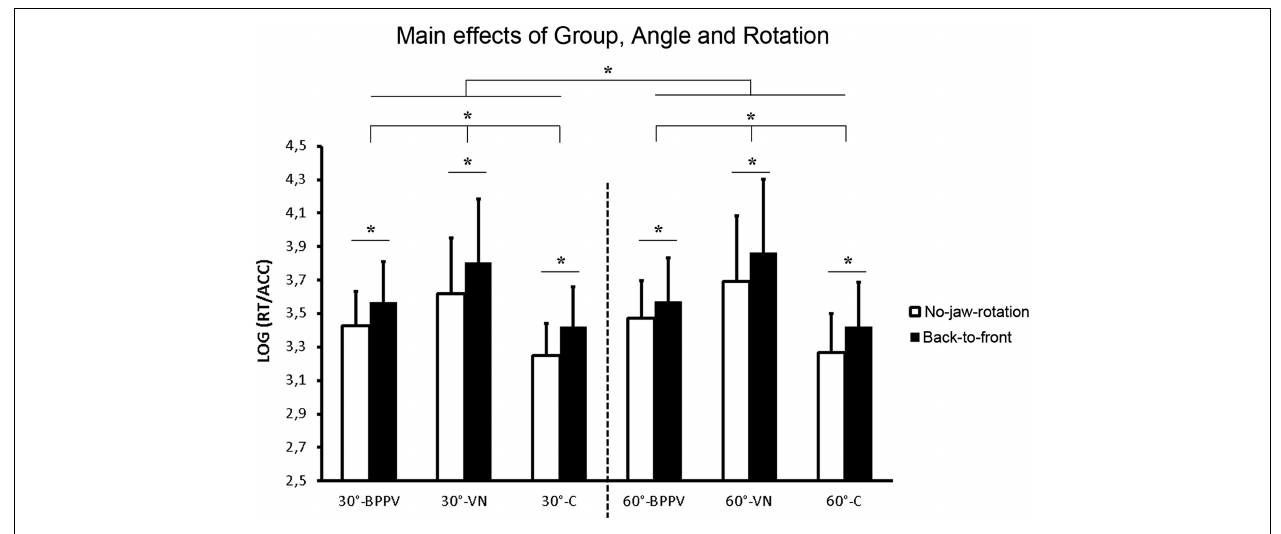
FIGURE 3 |The main effect of Group averaged betweenTask 1 and 2 figures and shown in all experimental conditions (30 ◦ /60 ◦ , Back-to-front/No-jaw rotations; mean ± standard deviation). * p < 0.05.